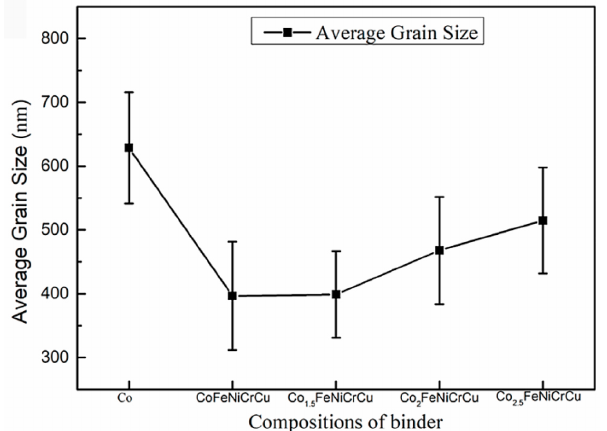
Figure 1. The average size of WC grains in the WC–10 wt.% Co alloy and in the WC-HEA (Co x FeNiCrCu, x = 1, 1.5, 2, 2.5) alloys sintered at 1400 °C. Reprinted with permission from Ref. [54]. Copyright 2022 Elsevier.